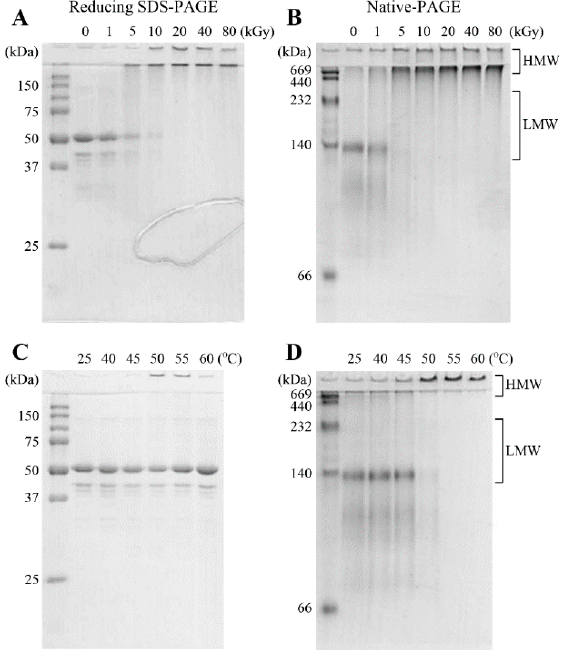
Figure 2. PAGE patterns of γ -irradiated or heat-treated AtTDX under denatured and native conditions. The γ -irradiated ( A , B ) or heat-treated ( C , D ) AtTDX proteins were separated by 12% SDS-PAGE under reducing condition ( A , C ) and 10% native-PAGE condition ( B , D ). The proteins were stained with Coomassie brilliant blue R-250. The numbers on the left side represent the molecular weights of the standard proteins.